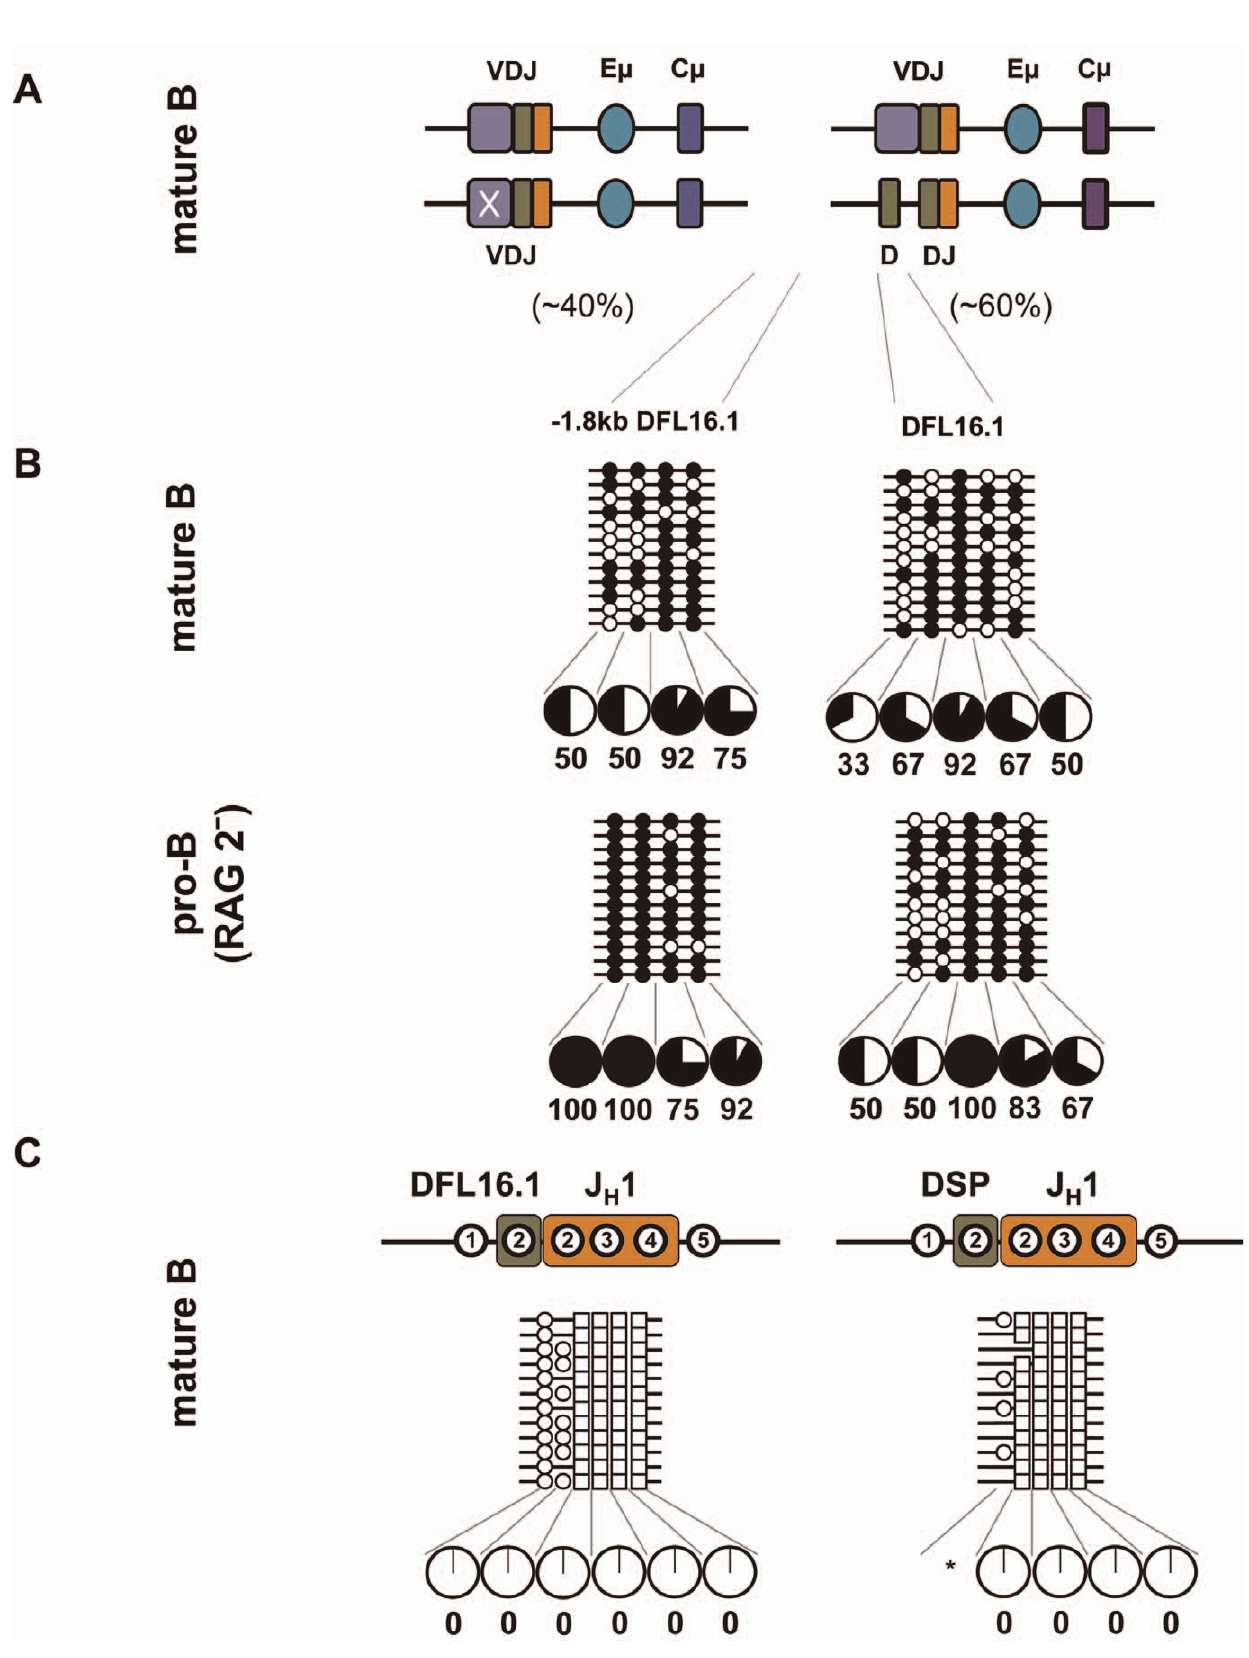
Figure 5. DNA methylation state of unrearranged and DJ H recombined alleles in mature B cells. (A) Mature B cells were purified from spleens of C57BL/6 mice, and the genomic DNA was subjected to bisulfite modification assays. 40% of these cells contain two VDJ H recombined alleles and the remainder contains one VDJ H and one DJ H recombined allele. (B) Amplicons corresponding to unrearranged DFL16.1 gene segment PLOS Biology |